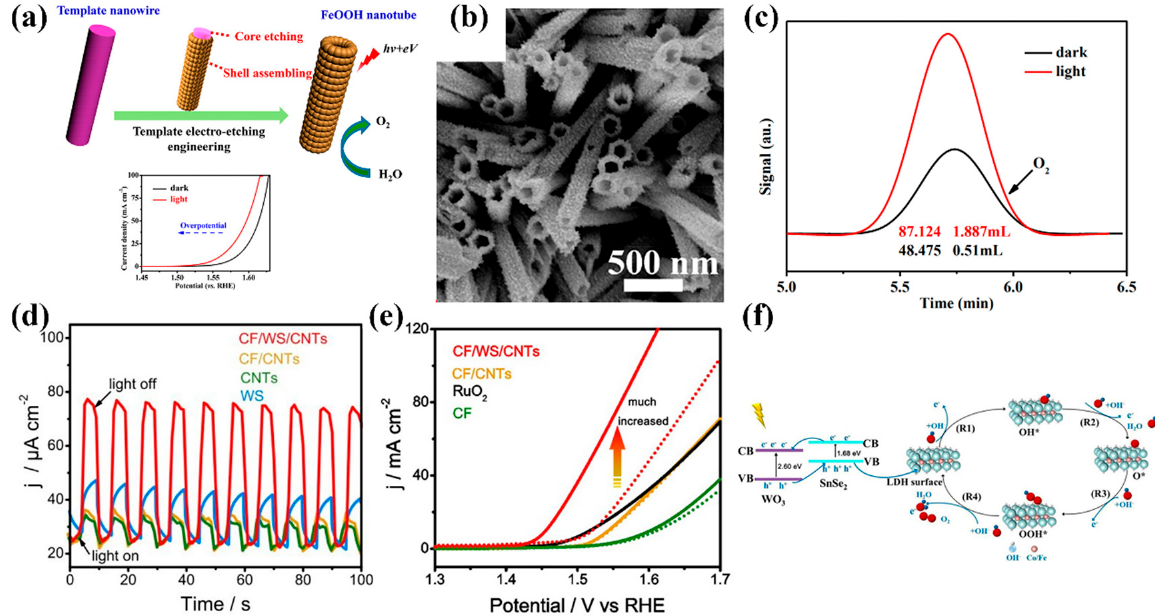
Figure 5. ( a ) Schematic diagram of the preparation process for FeOOH and the photoactive elec- trocatalytic OER curves, ( b ) SEM image of FeOOH nanotubes, and ( c ) the generated O 2 content of FeOOH under dark and light conditions. Adapted with permission from ref. [84]. Copyright 2018, American Chemical Society. ( d ) Transient photocurrent density of CF/WS/CNTs, ( e ) LSV curves of CF/WS/CNTs, and ( f ) schematic illustration of the photo-assisted mechanism of CF/WS/CNTs for OER under light irradiation. Adapted with permission from ref. [85]. Copyright 2022, Wiley— VCH.